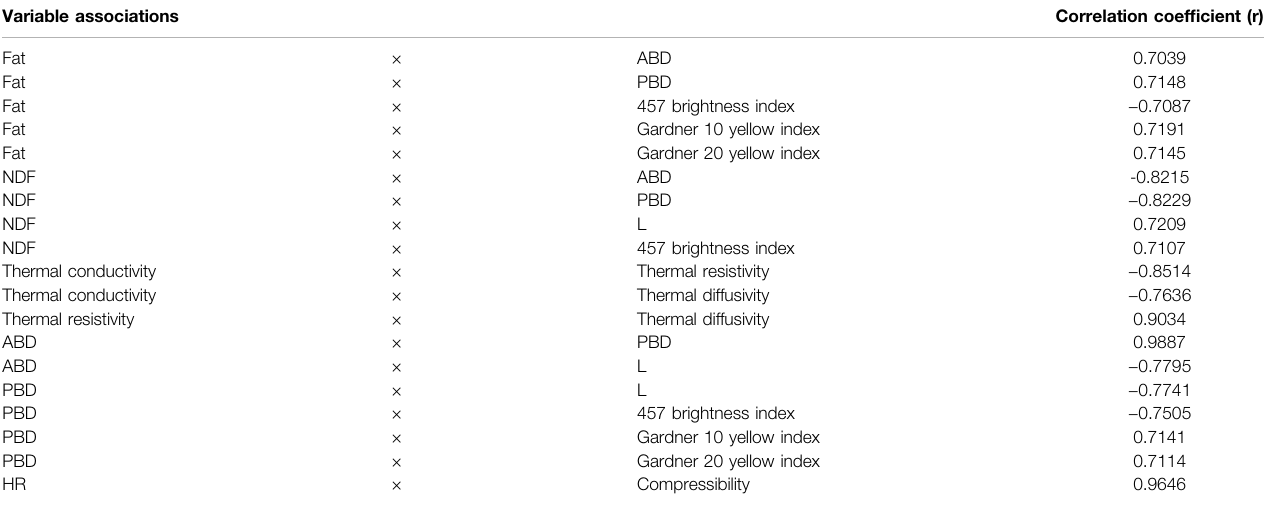
TABLE 3 | Signi fi cant ( p < 0.05) Pearson linear correlations between dependent variables (which are impacted by front end and back end processing conditions). Variable